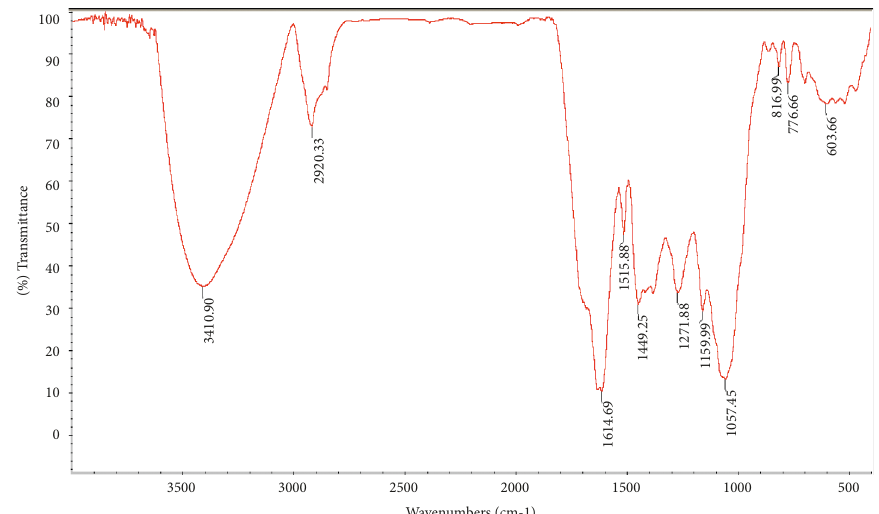
Figure 7: FTIR spectra of CuNPs using propolis (Gilan) extract from 400 to 4,000cm − 1 .